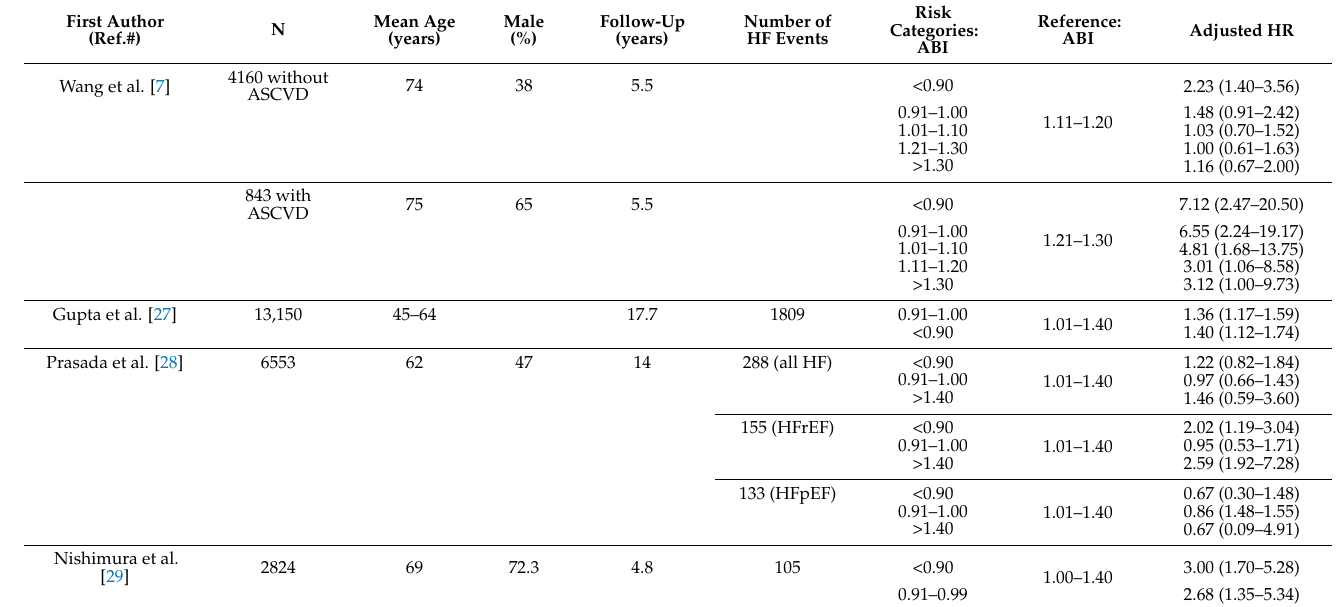
Table 2. The power of the ankle-brachial index as a risk predictor for heart